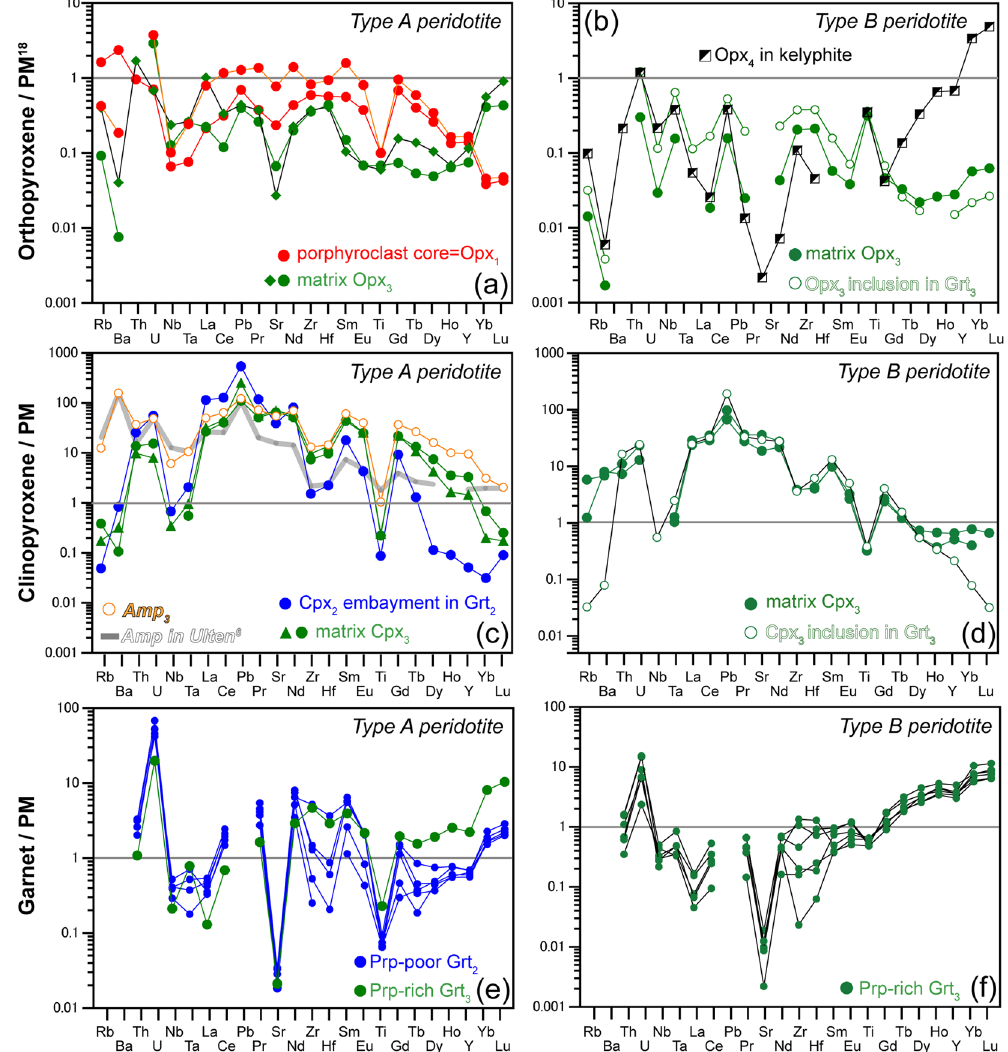
Figure 3. Panels (a,b) show primitive-mantle (PM) normalized 18 trace element patterns of orthopyroxene (Opx) in Type A and Type B peridotites, with stages are denoted by subscript numbers in the figure. Opx 1 displays a negative Ti anomaly and is rich in large ion lithophile element (LILE) and light REE (LREE). Opx 3 in Type A peridotites shows a convex REE pattern with an increase in heavy REE (HREE), whereas Opx 3 in Type B peridotite is depleted in HREE and shows a positive Ti anomaly. Opx 4 is moderately enriched in HREE. Panels (c,d) show PM-normalized trace element patterns of clinopyroxene (Cpx 2/3 ) and amphibole (Amp 3 ) in Type A and B peridotites. They show positive Pb anomalies and negative anomalies in high field strength elements. The trace element pattern of Amp in the Nonsberg peridotite 6 is shown for comparison. Panel (e) shows PM- normalized trace element patterns of Garnet (Grt 2/3 ) in Type A peridotites, in which pyrope (Prp)-poor Grts (~67 mol.%) are poor in HREE and Ti. Panel (f) shows trace element patterns of Prp-rich Grts (~70 mol.%) in Type B peridotites, which are rich in HREE and